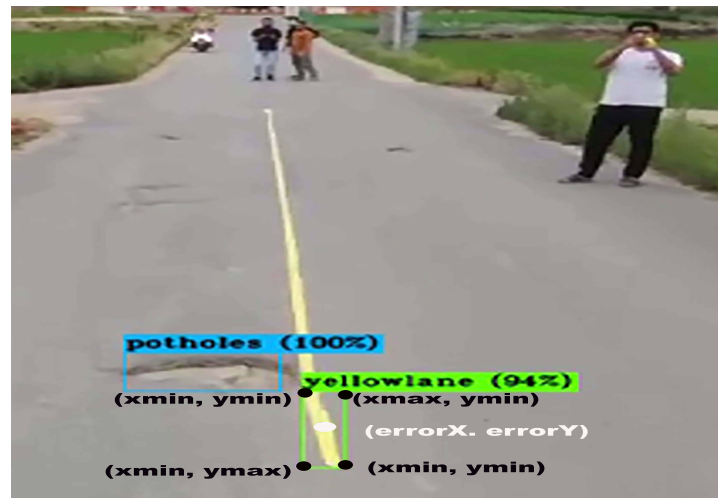
Figure 9. Bounding box position with detected object.